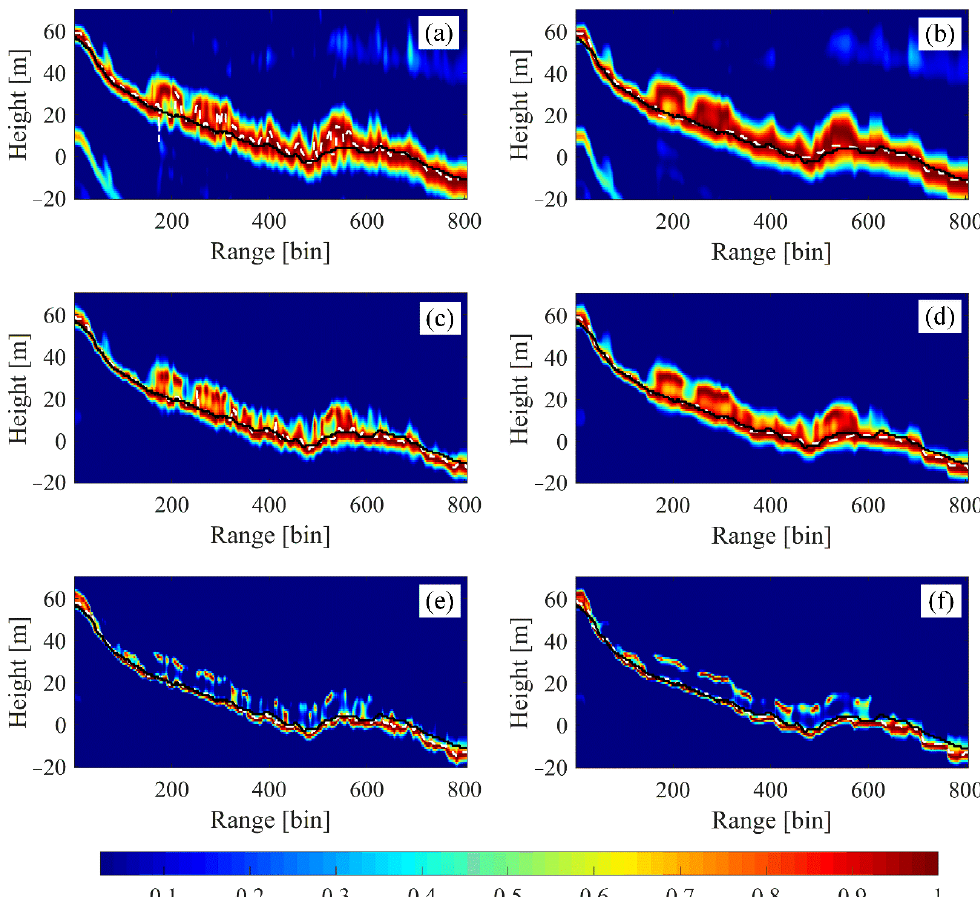
Figure 11. Profile line spectrum estimation results for the VV polarization channel: the solid black line is the LiDAR DTM, and the dashed white line is the estimated values; ( a ), ( c ), and ( e ) are, respectively, the estimation results of LM-based beamforming, Capon, and MUSIC; and ( b ), ( d ), ( f ) are the estimation results of NLM-based beamforming, Capon, and MUSIC, respectively.